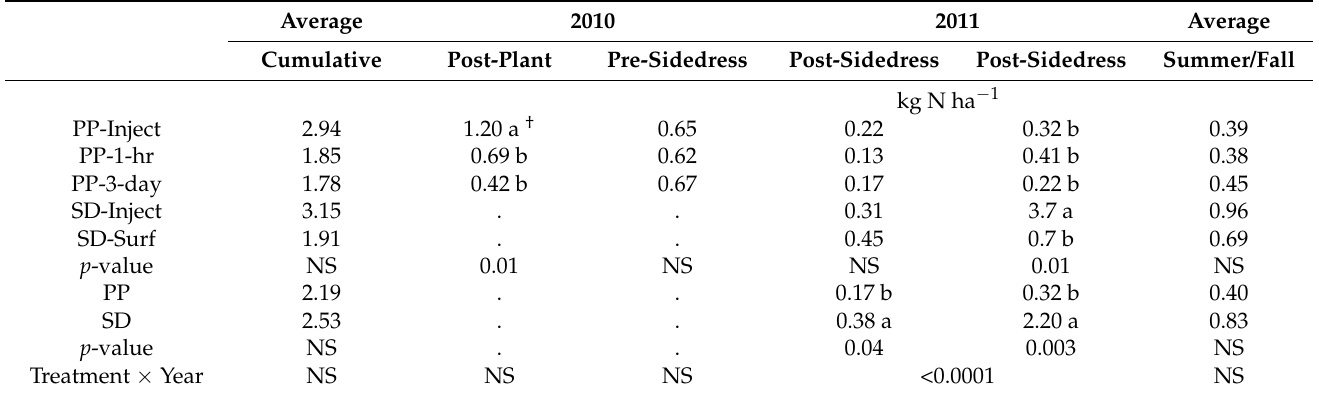
Table 4. Cumulative and seasonal cumulative nitrous oxide (N 2 O)